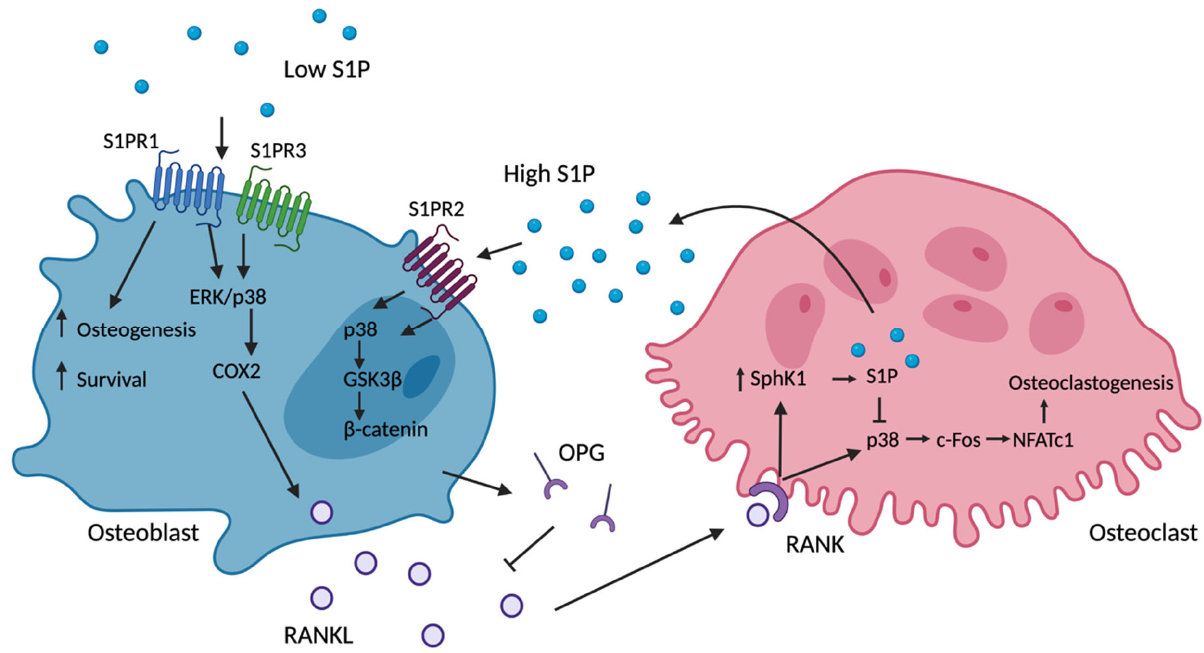
Figure 3. Osteoblast–Osteoclast Communication via S1P. S1P can act directly on osteoblasts via S1PR1/3 receptors to enhance osteoblast maturation and mineralisation [47]. S1PR1/3 also activates